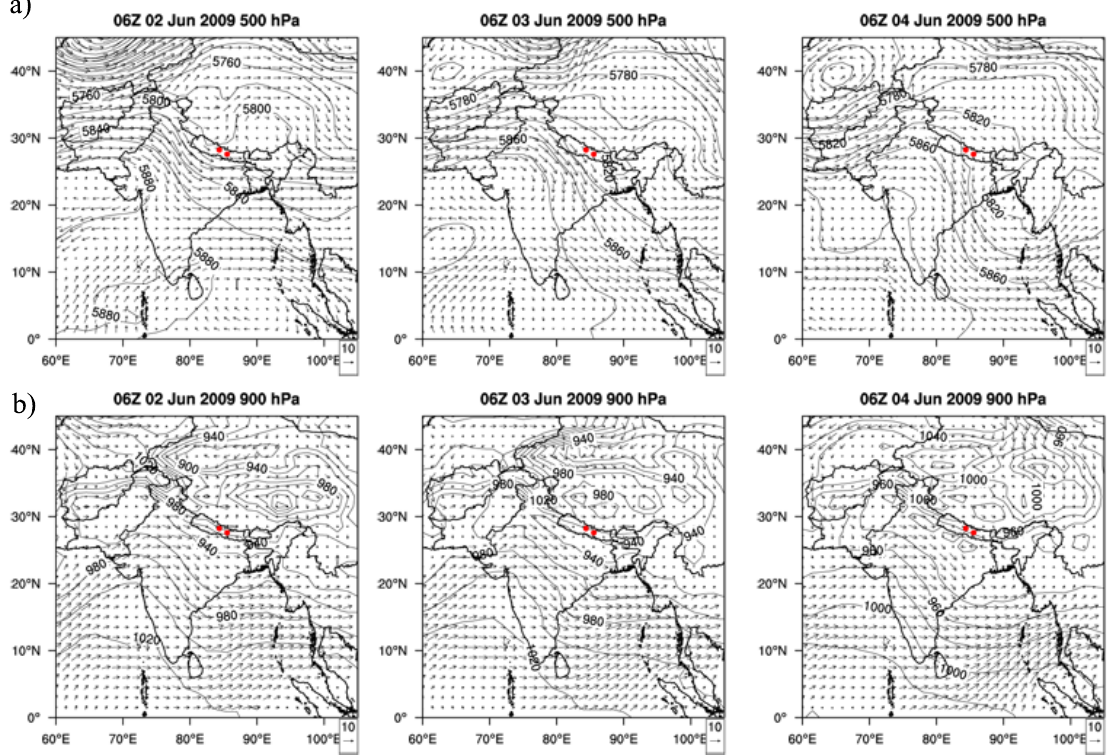
Fig. 13. Regional scale wind flow pattern during the sampling period at Site B (Besisahar) at (a) 500 hPa and (b) 900 hPa. The circular red dots represent the two sampling sites. Note the relatively stagnant flow as the synoptic wind (900 hPa) approaches the southern outermost foothills of Himalayas along the Nepal India border. Geopotential heights (m) and horizontal winds (m/s) were obtained from ERA Interim dataset. The contour lines for geopotential height are plotted at interval of 20m.